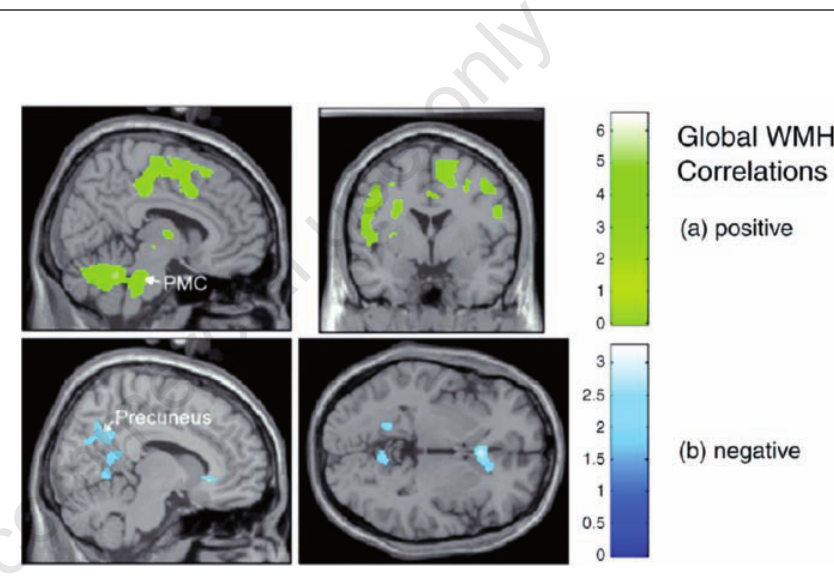
Figure 2. Cerebral white-matter changes and urinary dysfunction. The presence of white matter change in right inferior frontal regions and relevant tracts (anterior corona radiata and superior fronto-occipital fasciculus) is related with incontinence, incontinence severity, and degree of bother. ACR, Anterior corona radiata; Cing, Cingulate gyrus; Cing/hippo, Cingulate hippocampal portion. Reproduced with permission. 27